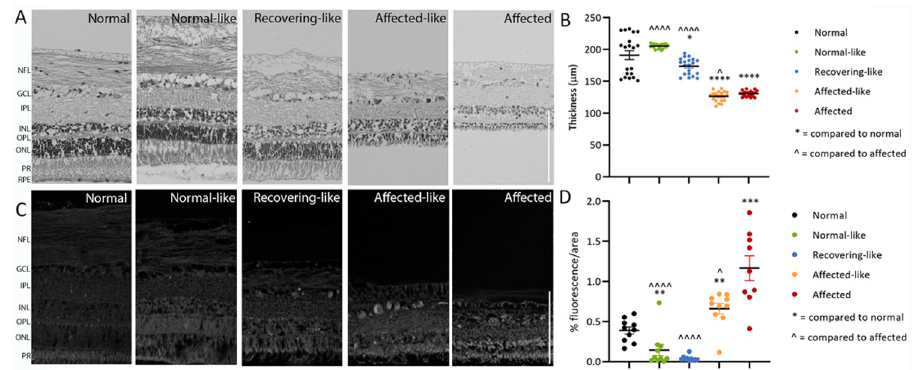
Fig 8. Retinal thickness and fluorescent storage body accumulation. Retinal thicknesses ( A, B ) in normal-like and recovering-like chimeric sheep retina were similar to those of normal controls, while affected and affected-like chimeras had significantly thinner retina. Fluorescent storage body accumulation ( C, D ) was highest in affected controls, although affected-like chimeras still had significantly more than normal controls. NFL: nerve fibre layer; GCL: ganglion cell layer; IPL: inner plexiform layer; INL: inner nuclear layer; OPL: outer plexiform layer; ONL: outer nuclear layer; PR: photoreceptor layer; RPE: retinal pigment epithelium. � and ˆ indicate P < 0.05, �� indicates P < 0.01, ��� indicates P < 0.001, ���� and ˆˆˆˆˆ indicate P < 0.0001. Scale bars represent 100 μ m.